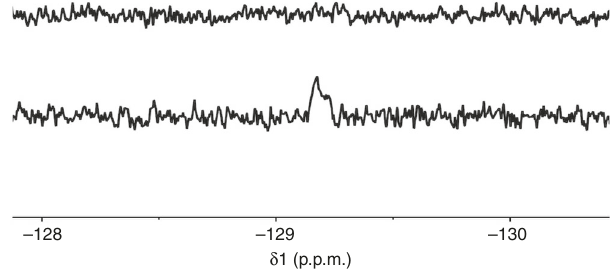
Fig. 6 Sub-picomole detection combining photo-CIDNP and microcoil NMR technology. Top: 19 F NMR spectrum of a sample containing 0.4 mM of p- fl uorophenol, which cannot be detected. Bottom of fi gure: The photo- CIDNP spectrum under fl ow conditions of a 0.8 μ M p- fl uorophenol sample. This corresponds to detection of just 0.8 picomole of material per μ L. The number of accumulated scans is 14 in both